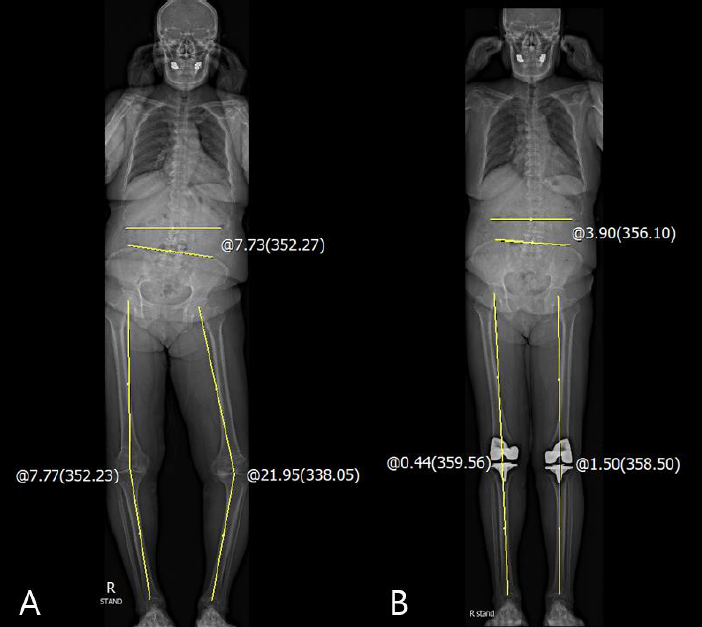
Figure 3. Corrected closed to neutral knee alignment affected the coronal pelvic obliquity. ( A ) Measurement of the preoperative coronal HKA angle: coronal HKA Rt-Lt = −14.18° and pelvic obliquity: −7.73°; ( B ) measurement of the postoperative coronal HKA angle: coronal HKA Rt-Lt = −1.06° and pelvic obliquity: −3.90°.